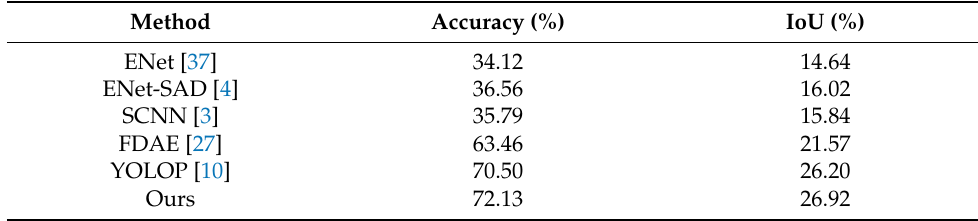
Table 2. Lane line segmentation results on the BDD100K dataset.